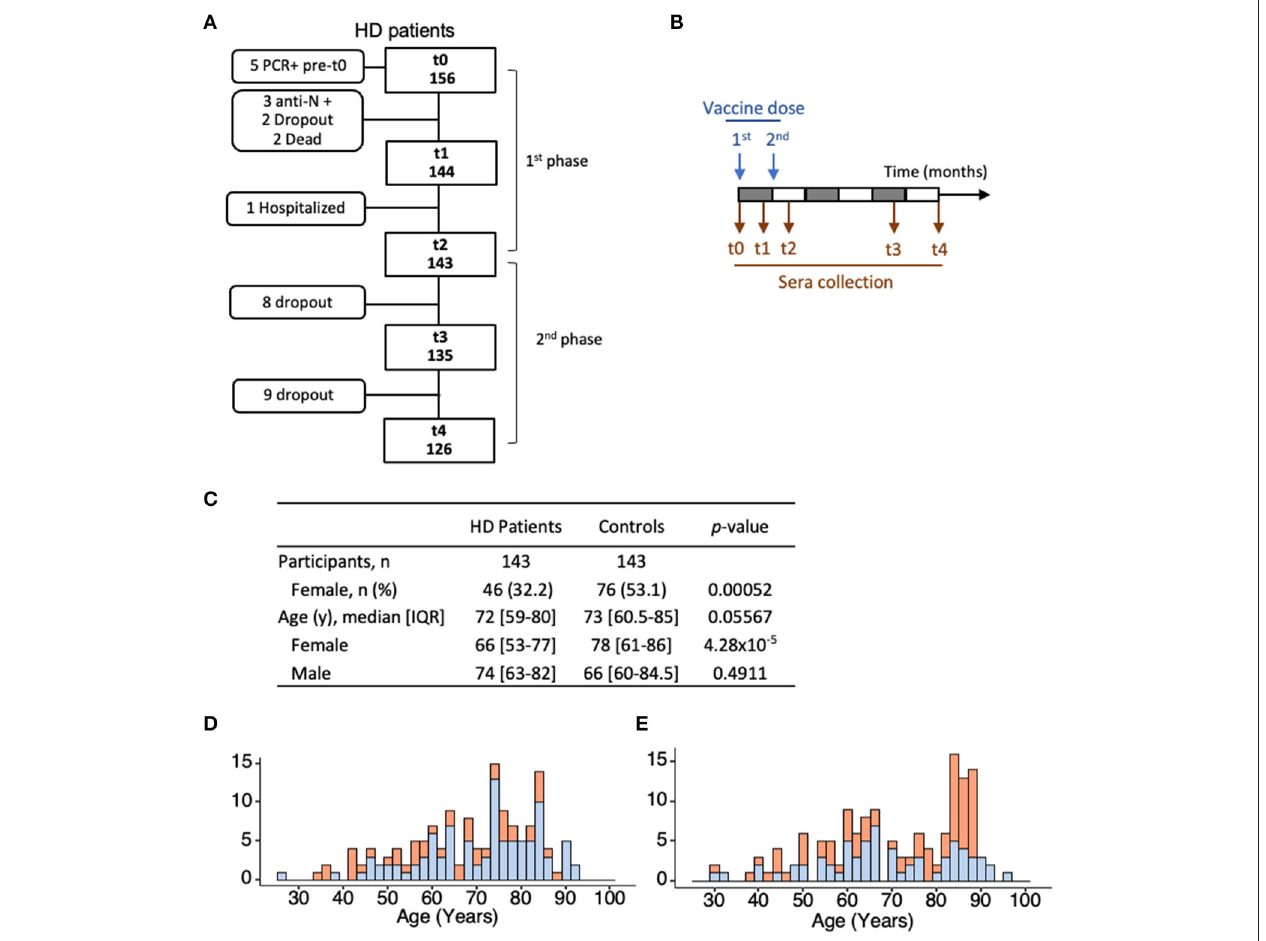
FIGURE 1 | Patient and control cohorts. (A) Enrolment and funneling of HD patients during the first and second phases of the study, showing concordance to the study design (straight boxes), and exclusion criteria to the antibody analysis, dropouts, and death (rounded boxes). (B) Serum collections were performed at the time of inoculation of the first dose (t0); 21 days post-first dose (t1) and 42 days post-first dose (t2), and thereafter, at t3 (140 days post-first vaccine dose) and t4 (180 days post-first vaccine dose). (C–E) Age and sex profiles of the 143 patients and 143 controls analyzed for the first phase of the study. Differences in age and sex distribution between the two cohorts were evaluated using the Wilcoxon rank sum test (with continuity correction) and Pearson’s Chi-squared test (with Yates’ continuity correction), respectively. HD, hemodialyzed patients; n , number of individuals with a given event; IQR, interquartile